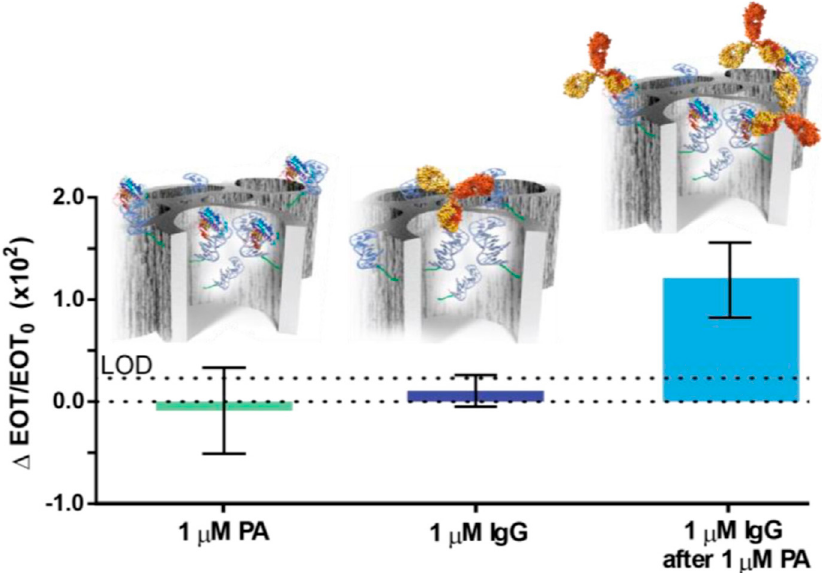
Figure 3. Sensitivity enhancement of the PAA-functionalized PSiO 2 biosensor. Averaged optical response (relative EOT) of the biosensor upon exposure to 1 M of: PA, IgG or both in a successive manner. Schematic illustration of biomolecules captured by the aptamers within the porous scaffold. Upper dashed line indicates the LoD value. Differences between both single exposures (of PA or IgG) and the sandwich assay are statistically significant ( p < 0.05, n ≥ 3). Reproduced with permission from [58].